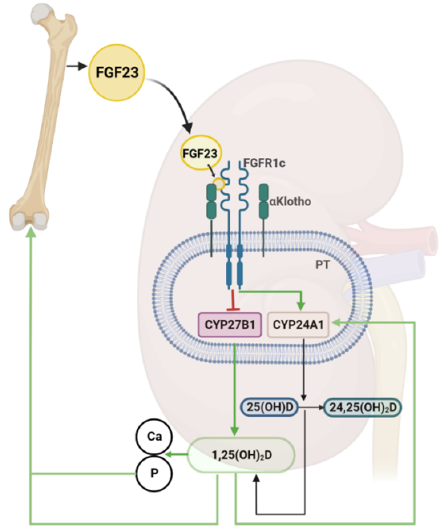
Figure 2. Bone-kidney axis. Fibroblast growth factor 23 (FGF23) is mainly produced in bone under physiological conditions. The active vitamin D hormone (1,25(OH) 2 D) and phosphate (P) stimulate FGF23 secretion from bone. Circulating FGF23 binds to a receptor complex consisting of FGF receptor-1c (FGFR1c) and of the co-receptor α Klotho in proximal tubules (PT) of the kidney. FGF23 signaling inhibits transcription of 1 α -hydroxylase ( CYP27B1 ), the key enzyme for vitamin D synthesis, while stimulating transcription of 24-hydroxylase ( CYP24A1 ), the main enzyme responsible for vitamin D catabolism. 25-hydroxyvitamin D (25(OH)D) produced in the liver and circulating in the bloodstream is converted in the kidney into 1,25(OH) 2 D by CYP27B1, or into 24,25(OH) 2 D by CYP24A1. 1,25(OH) 2 D stimulates intestinal absorption of calcium (Ca) and P, thereby increasing the blood concentrations of both minerals. Arrows indicate the direction and nature of regulation (green, stimulation; red, inhibition). Created with BioRender.com (Biorender 2022, Toronto, Ontario,